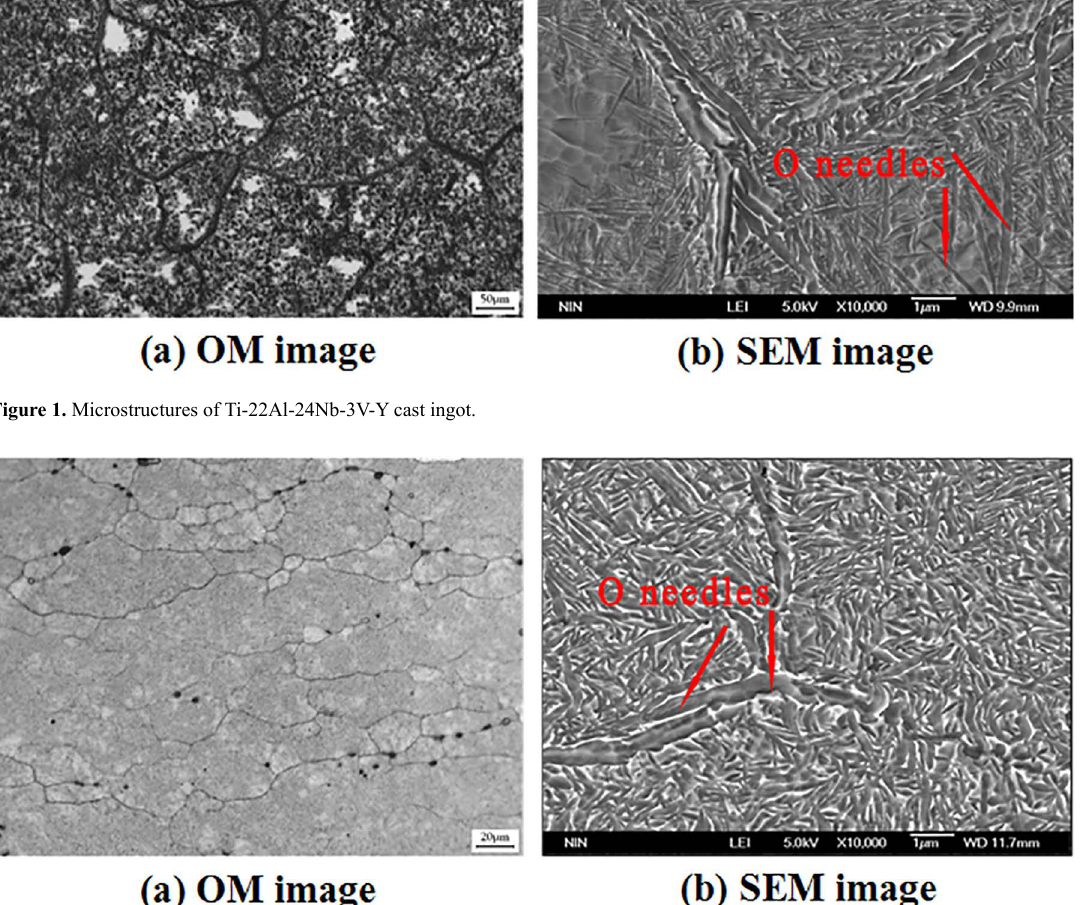
Figure 2. As-forged microstructures of the present Ti